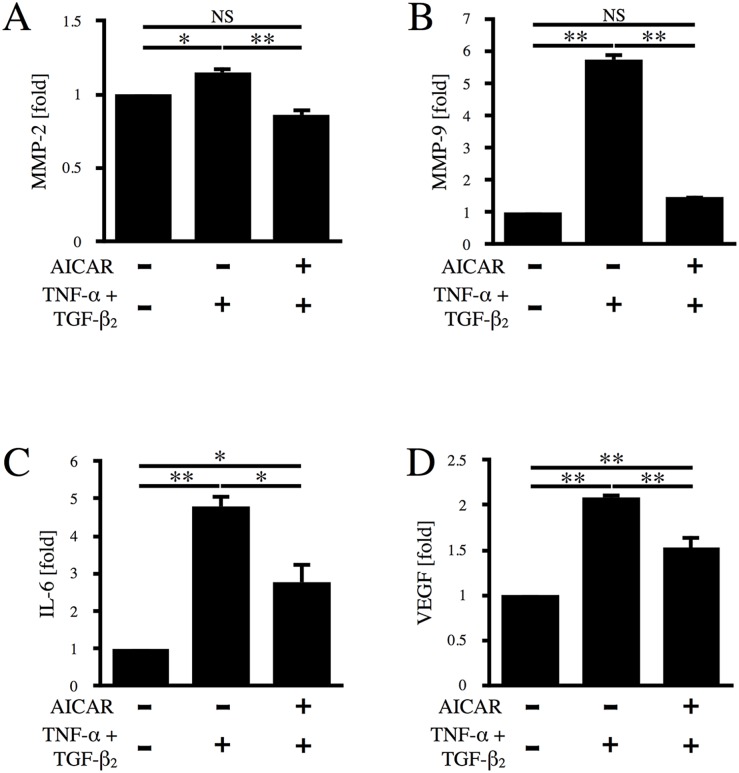
Effect of AICAR on TNF-α/TGF-β2-induced upregulation of MMP-2, MMP-9, IL-6, and VEGF.The levels of MMP-2 (A), MMP-9 (B), IL-6 (C), and VEGF (D) in culture medium were determined by ELISA after 24 h of stimulation with TNF-α/TGF-β2 in the absence or presence of AICAR. *, p < 0.05; **, p < 0.01; NS, not significant. Error bars, S.E.